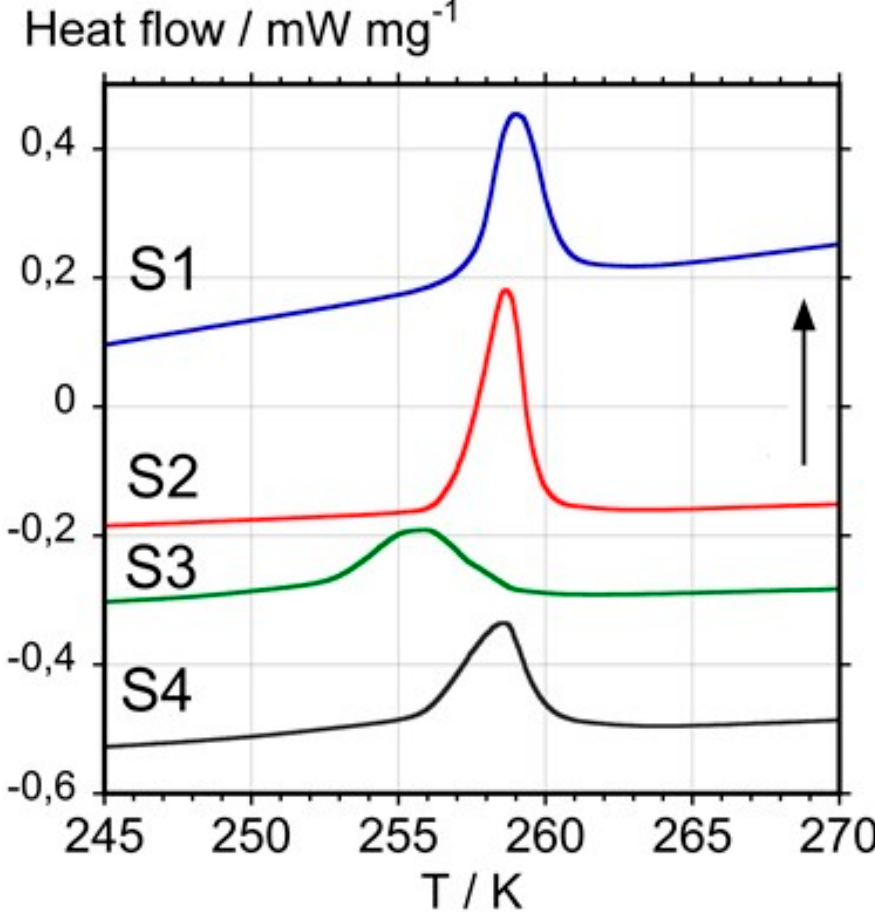
Figure 3. Differential scanning calorimetry curves obtained with samples S1, S2, S3, and S4 at a heating rate of 10 K min − 1 . The vertical arrow indicates the endothermic direction.